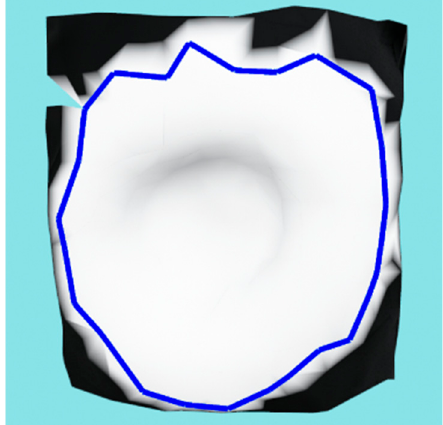
Figure 10. Initial wound contour shown in blue color on the meshed wound surface with binary mask texture.